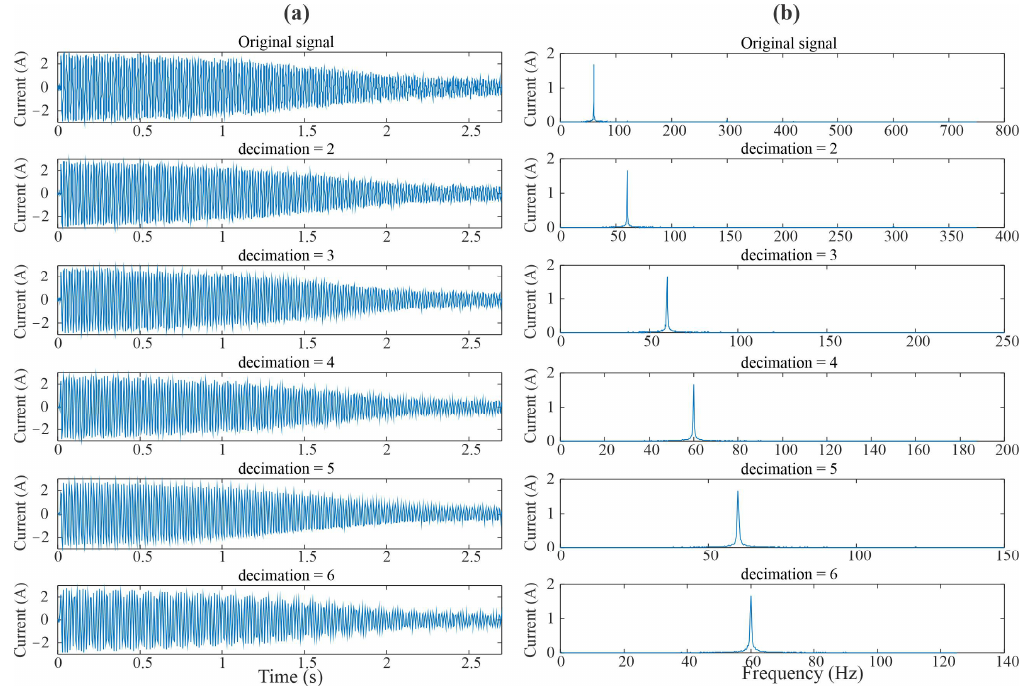
Figure 7. ( a ) Original and decimated current signals obtained using the start-up regime, and ( b ) their spectrums estimated by Fourier transform.